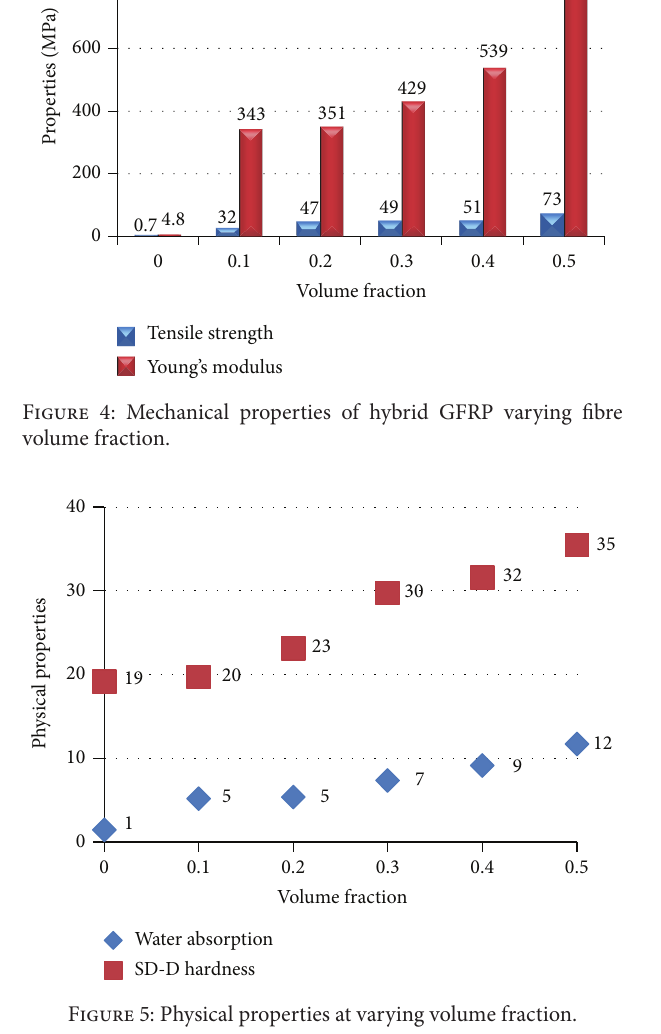
Figure 5: Physical properties at varying volume fraction.